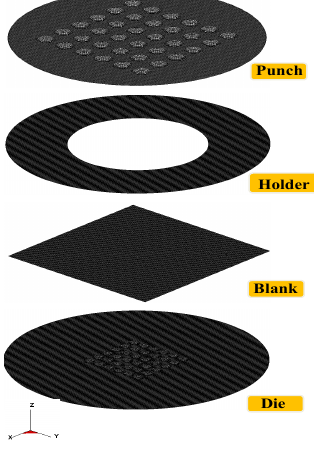
Figure 2. Finite element model.